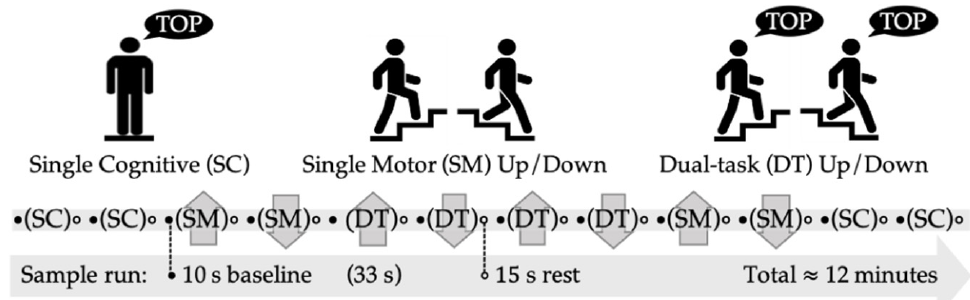
Figure 2. Sample run composed of 12 counterbalanced blocks. The single cognitive (SC) blocks had participants stand and perform a simple reaction time task. The single motor (SM) blocks had participants ascend or descend the stairs. The dual-task (DT) blocks had participants ascend or descend the stairs while responding to a simple reaction time task. Each block was preceded by a 10 s baseline and followed by a 15 s rest period.